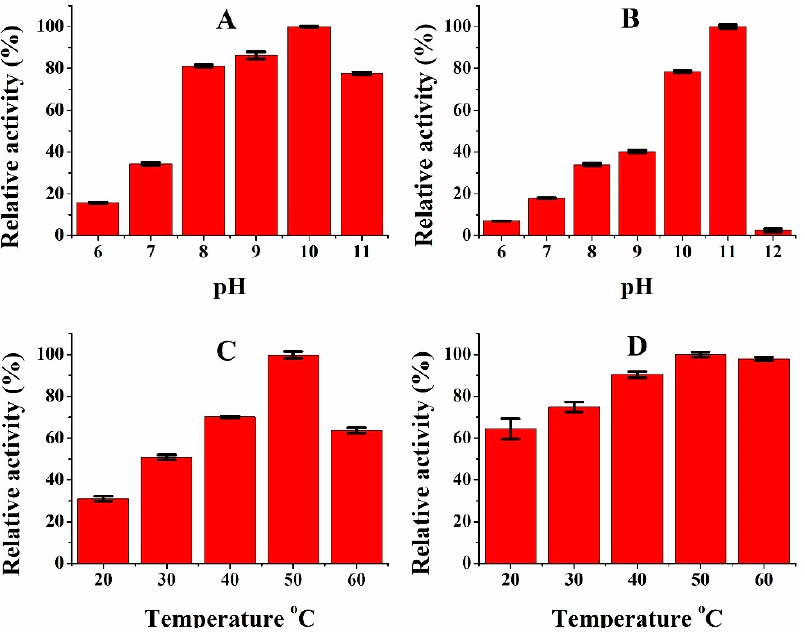
Figure 1. Effects of pH and temperature on enzyme activities of (2 S , 3 S )-BDH ( A , C ) and (2 R , 3 R )-BDH ( B , D ) using 1,2-BD mixture as substrate.